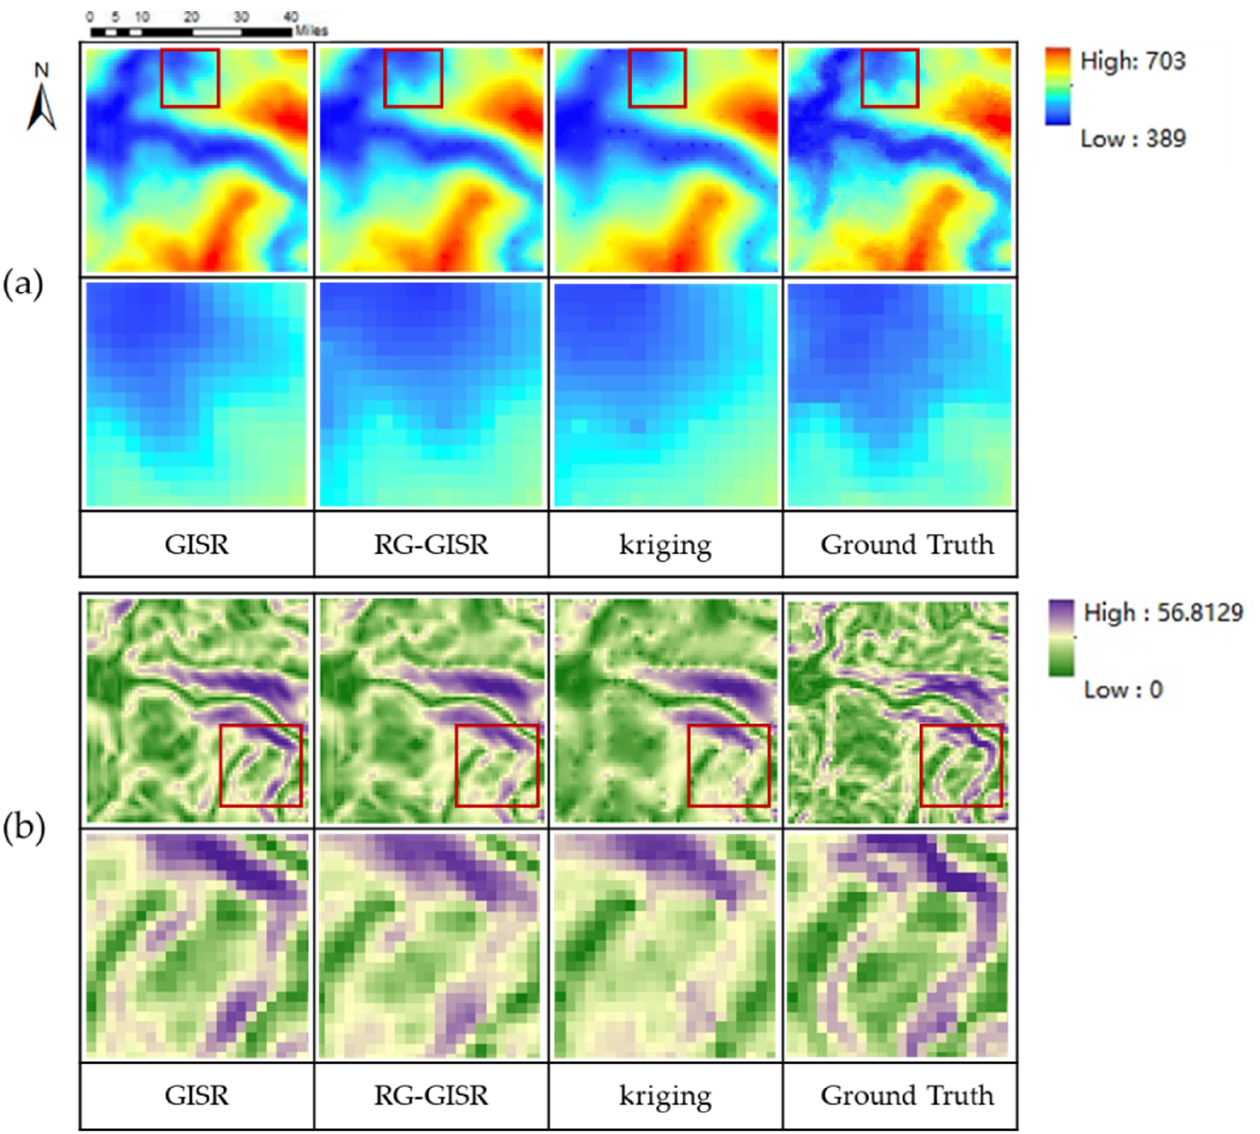
Figure 13. Visualization results of the role of different modules: ( a ) is the DEM SR result, and ( b ) is the DEM SR slope (RG-GISR means the global information supplement module was removed; The details in the red box are in the next row).